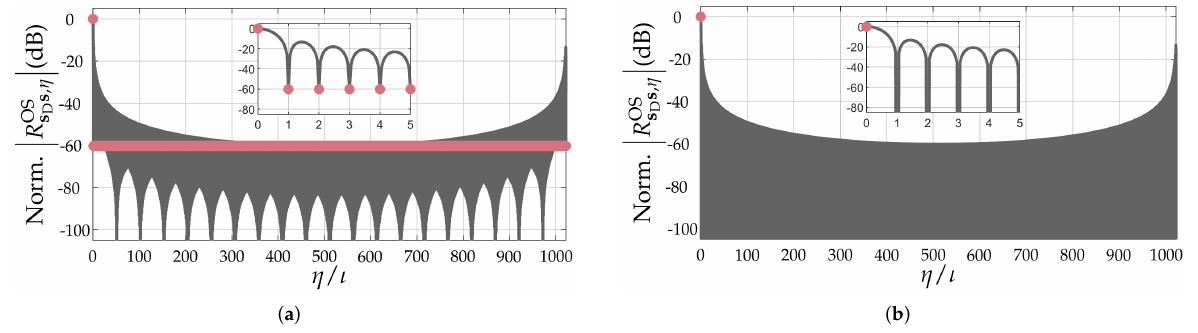
Figure 3. Comparison between Nyquist-sampled ( of m-sequence of length N PRBS = 1023 and ( b ) ideal PACF of an hypotetical sequence of length N PRBS =